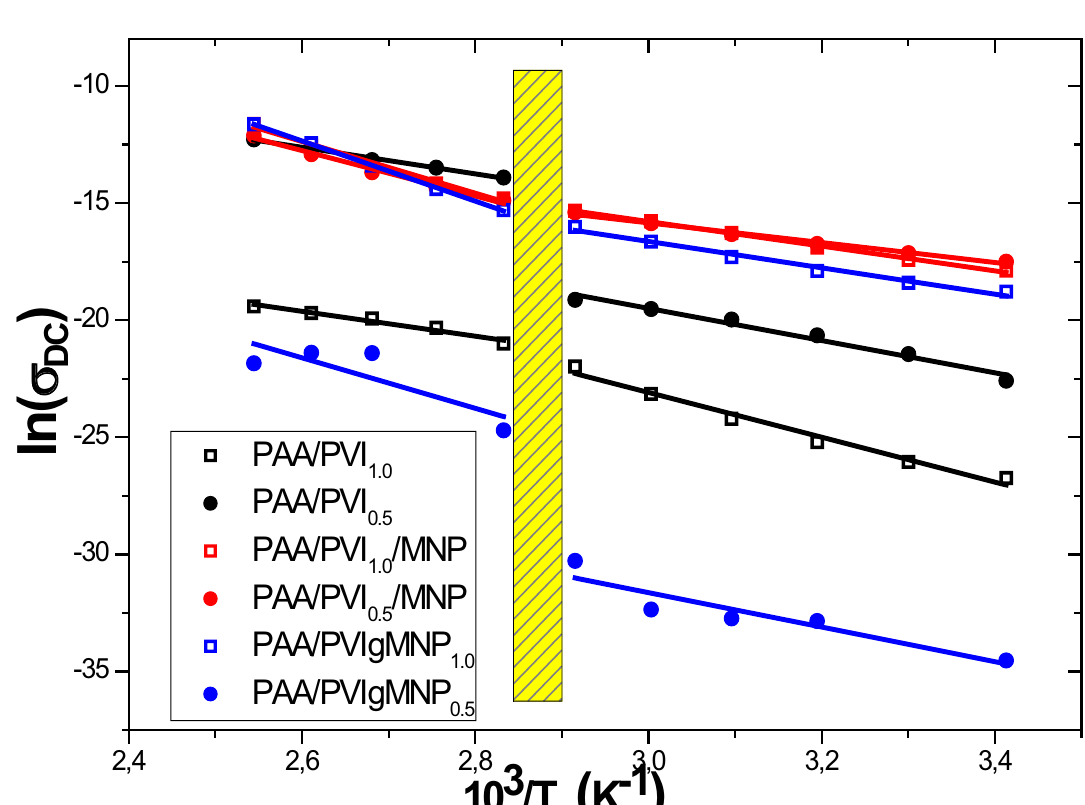
Figure 11. (cid:55)(cid:75)(cid:72)(cid:3)(cid:39)(cid:38)(cid:3)(cid:70)(cid:82)(cid:81)(cid:71)(cid:88)(cid:70)(cid:87)(cid:76)(cid:89)(cid:76)(cid:87)(cid:76)(cid:72)(cid:86)(cid:3)(cid:68)(cid:81)(cid:71)(cid:3)(cid:87)(cid:75)(cid:72)(cid:76)(cid:85)(cid:3)(cid:287)(cid:87)(cid:86)(cid:3)(cid:73)(cid:82)(cid:85)(cid:3)(cid:36)(cid:12)(cid:3)(cid:51)(cid:40)(cid:16)(cid:20) B) PE-2 C) NPE-1 D) NPE-2 E) NPE-3 F) NPE-4 temperatures.